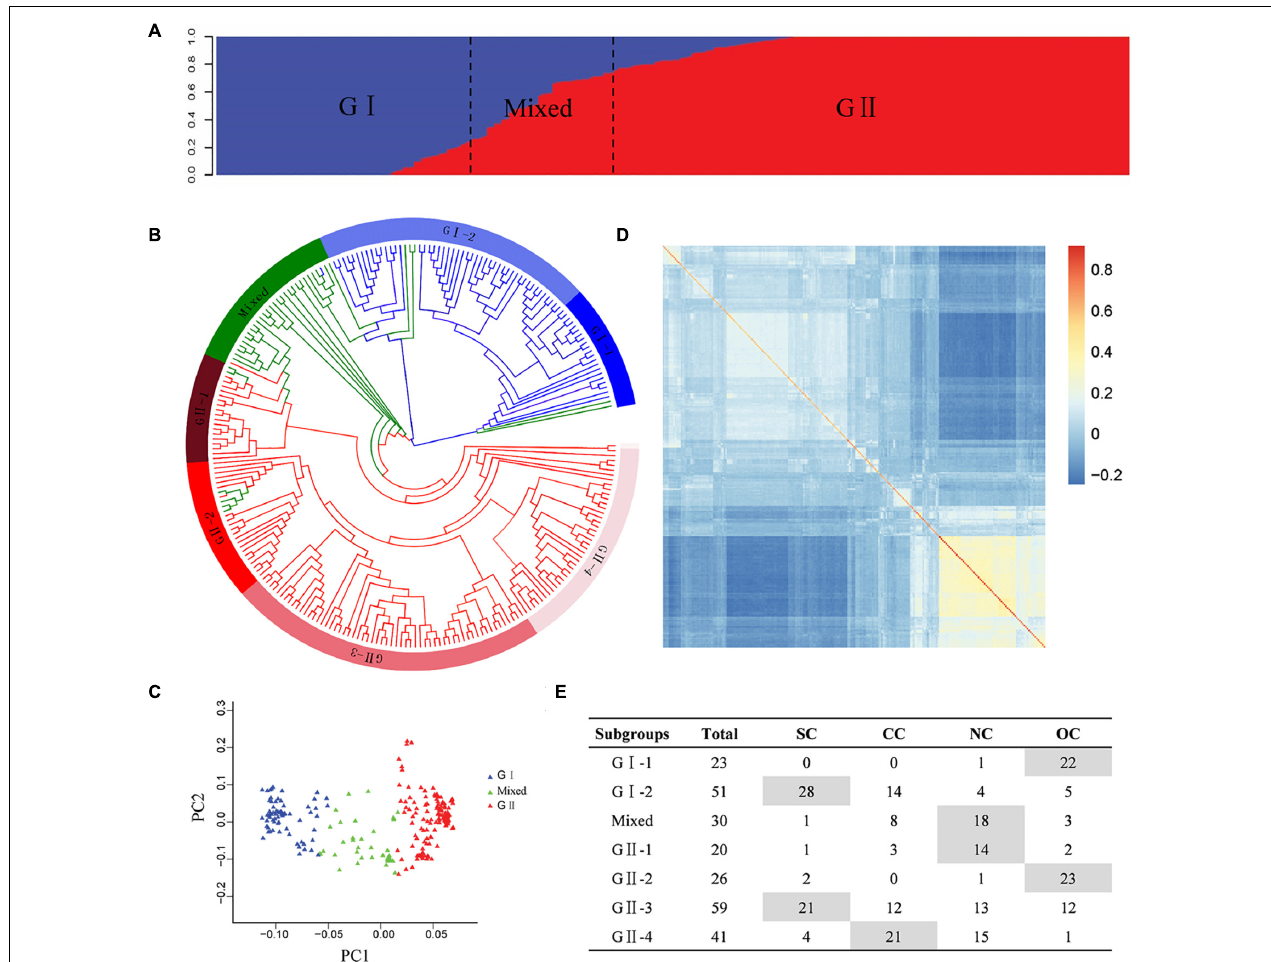
FIGURE 2 | Genetic structures of the Chinese peanut mini-core collection. (A) Population structure. (B) Phylogenetic tree. The layer rings indicate the group and subgroup name. (C) Principal component analysis. (D) Heat map of pairwise relative kinship estimates. (E) The geographic origin of each accession in each cluster. SC, southern China; CC, central China; NC, northern China; OC, countries other than China. The information of botanical subspecies, origin geographic region, and group classification of each accession is provided in Supplementary Table 1